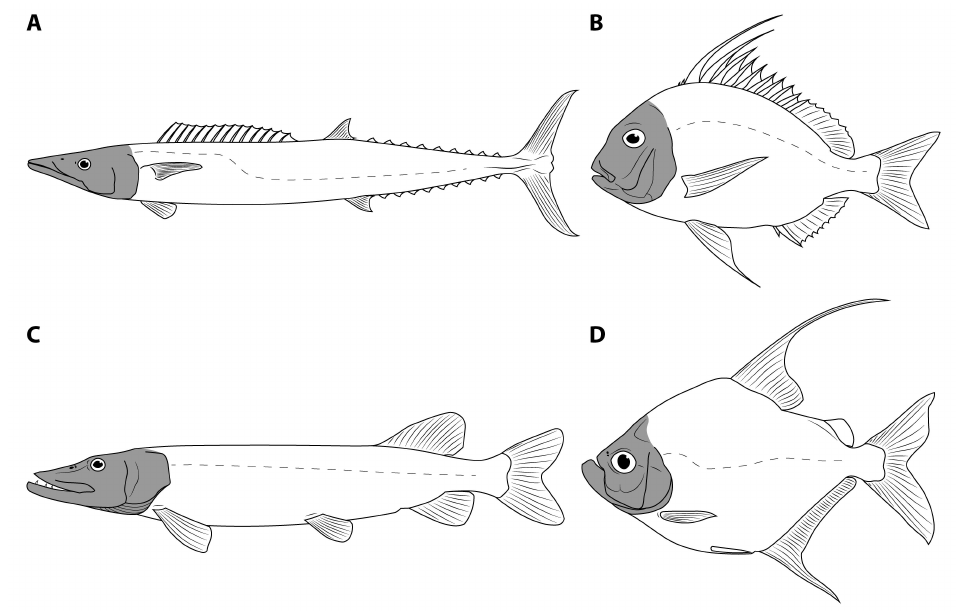
Figure 2. Elongate-bodied ( A , C ), and compressiform ( B , D ) acanthopterygian ( A , B ) and non- acanthopterygian ( C , D ) fishes, showing how short fishes have short heads and long fishes have long heads. ( A ), Acanthocybium solandrei (Scombridae), drawn from FSBC 6267. ( B ), Catoprion abscondidus (Serrasalmidae), modified from Bonani Mateussi et al. [43]. ( C ), Esox lucius (Esocidae), modified from Casselman et al. [44]. ( D ), Argyrops spinifer (Sparidae), modified from Randall [45]. Drawings by Russell